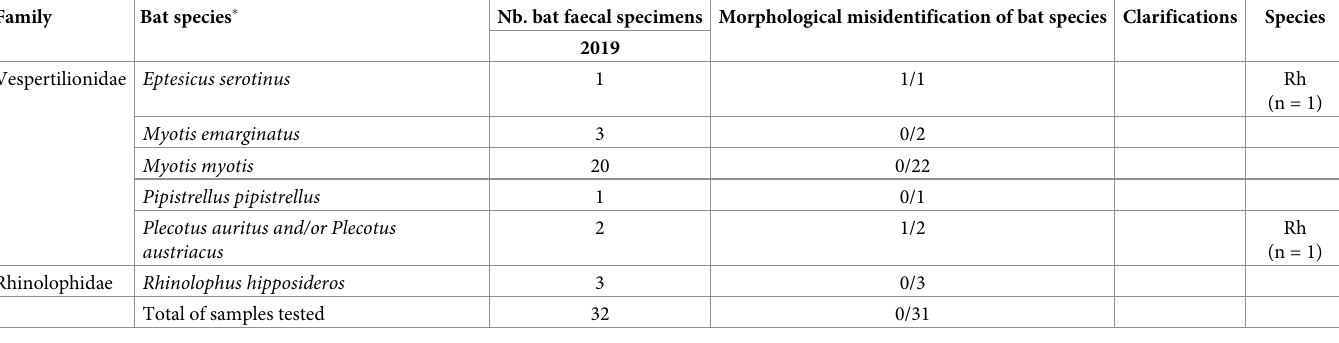
Table 6. Results of PCR on the partial cytochrome b gene and species misidentification of bat guano samples compared with morphological